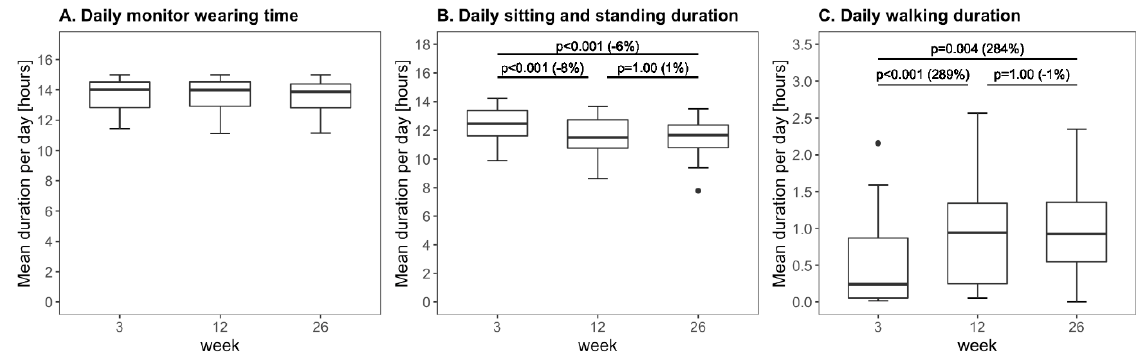
Figure 2. Boxplots of the daily monitor wearing time, daily sitting, and standing time, and daily walking time measured with the sensor system. The percentage between brackets represents the change in median value between time points.